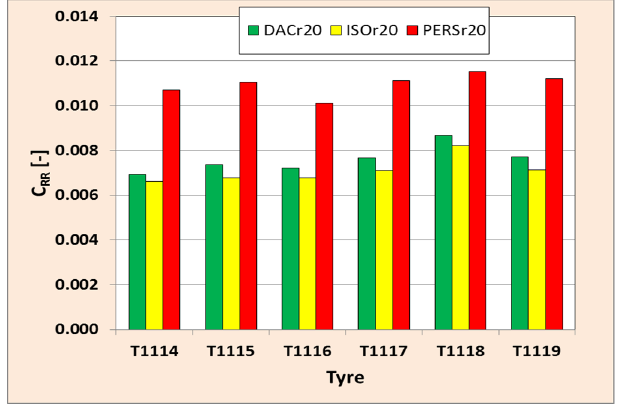
Figure 9. Results of laboratory rolling resistance measurements for truck tires (PERS is the PERS ‐ HET ‐ type).